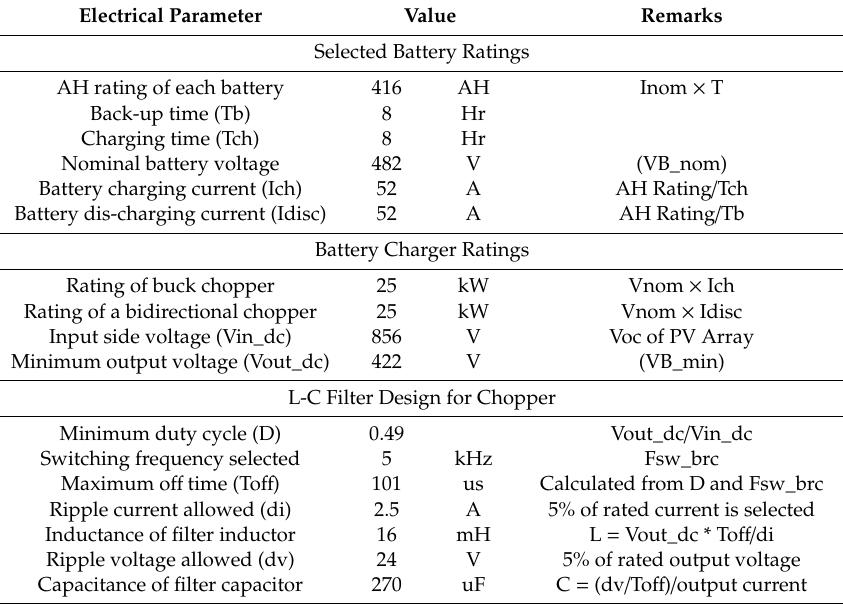
Table 3. Design calculations for the battery charger.